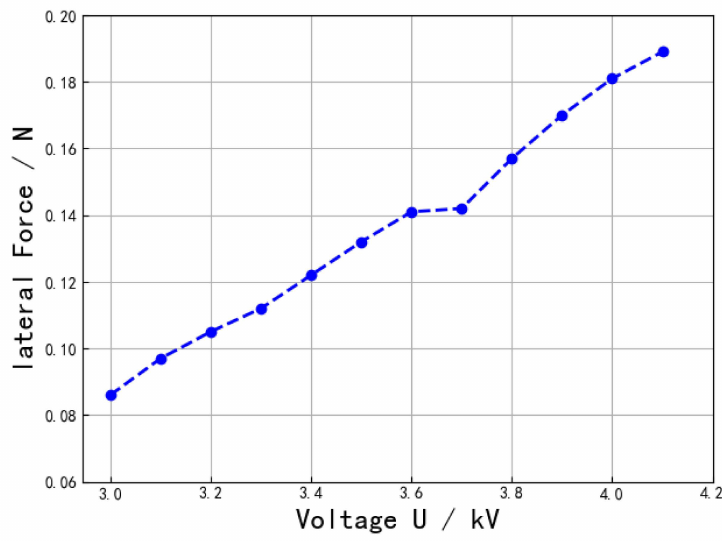
Figure 15. Output lateral force–voltage curve of the test cell.